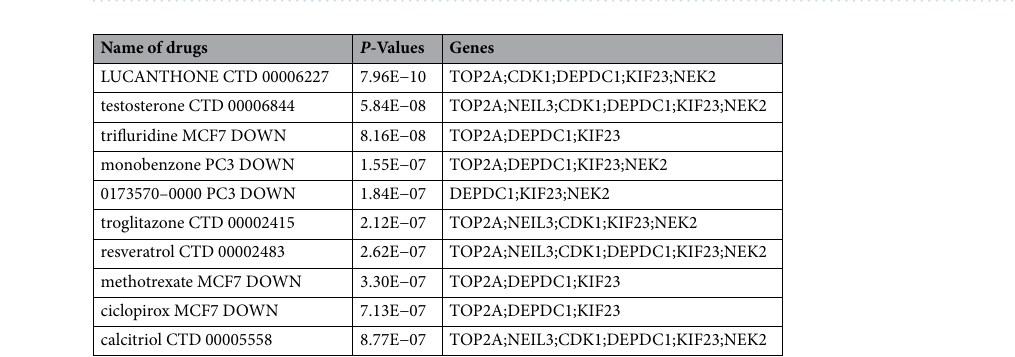
Table 4. Prediction of top 10 candidate drugs for EBV, SLE, and